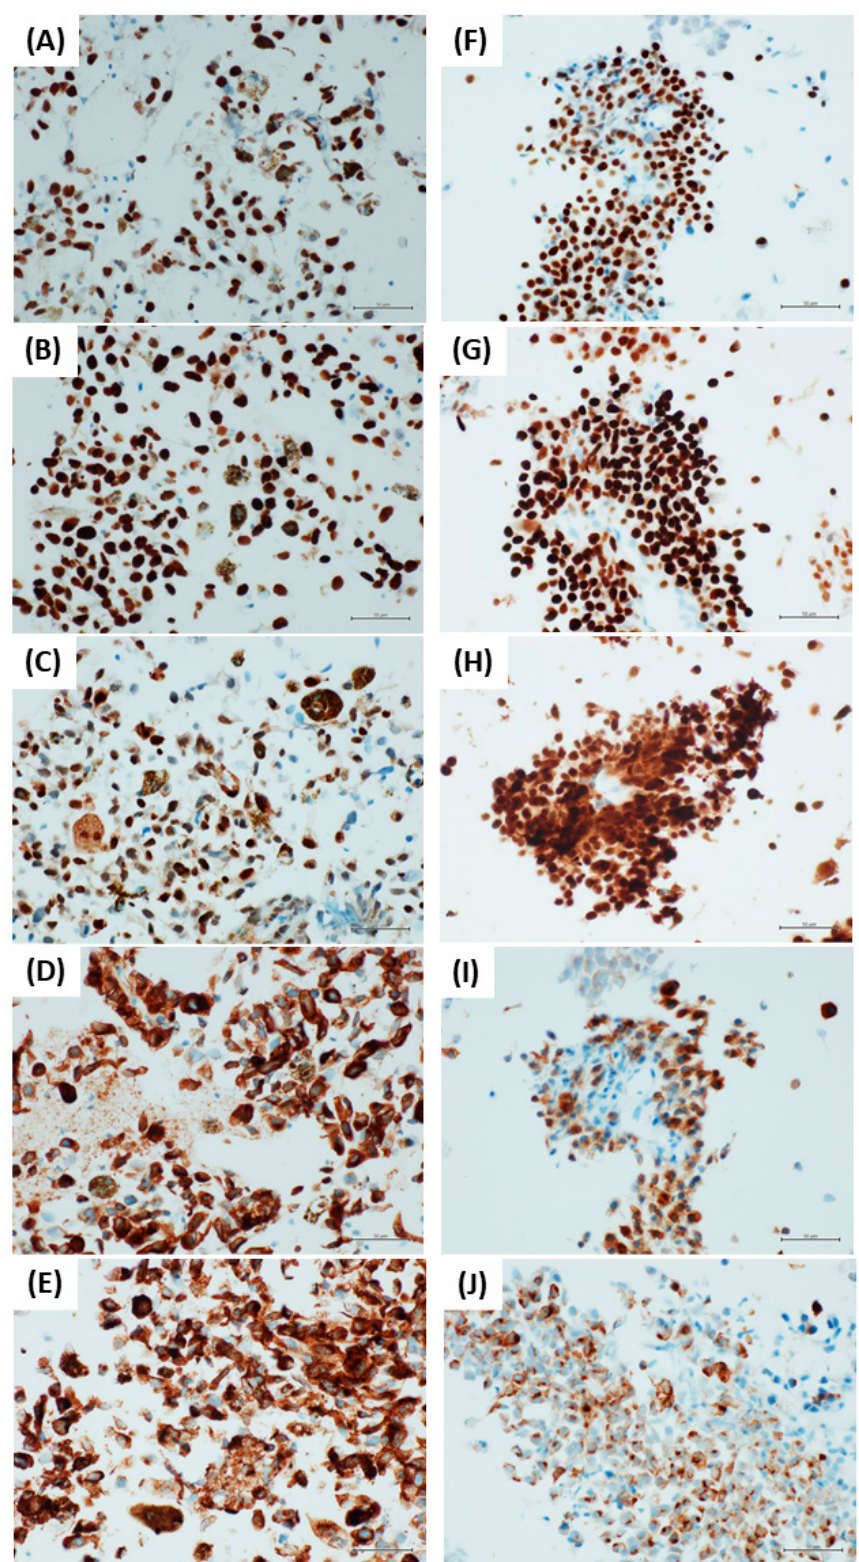
Figure 2. Immunohistochemistry in a case of heavily pigmented melanoma metastasis ( A – E ), and in a case of slightly pigmented melanoma metastasis ( F – J ) (( A , F ): PRAME, ( B , G ): SOX10, ( C , H ): S100, ( D , I ): Melan-A, and ( E , J ): HMB45). (( A – J ): immunostain, original magnification 400×).